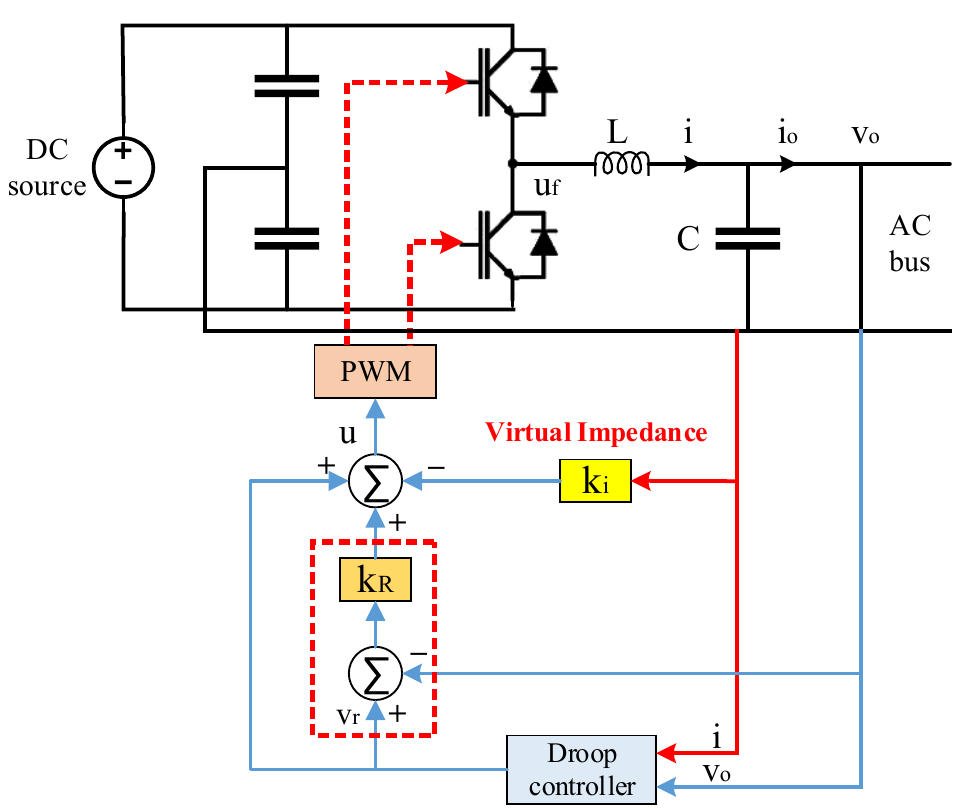
Figure 13. Modifying the voltage control loop to create the resistance coupling impedance and increase the voltage quality.